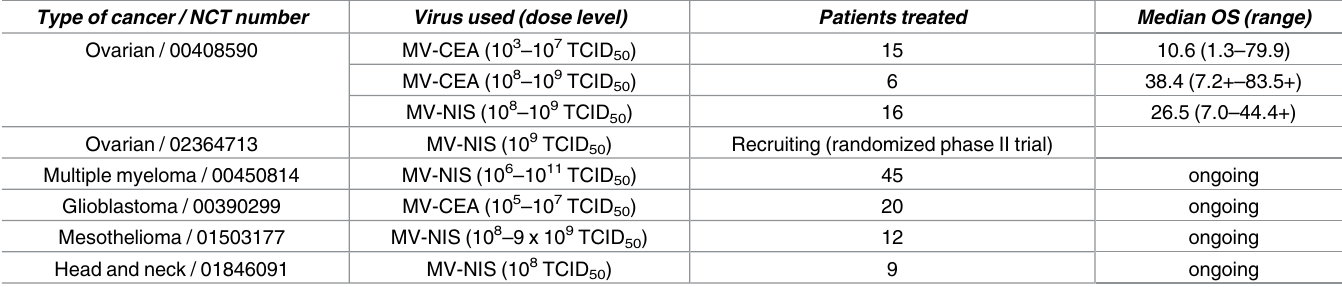
Table 1. Clinical trials with oncolytic